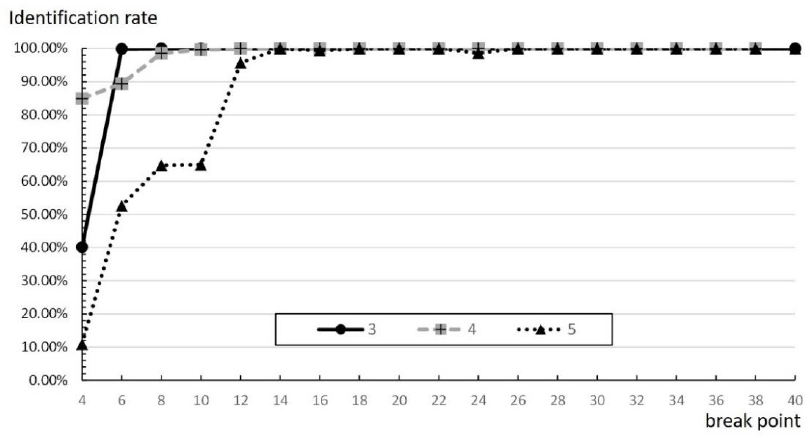
Figure 16. Identification rate of different velocities at different breakpoints.